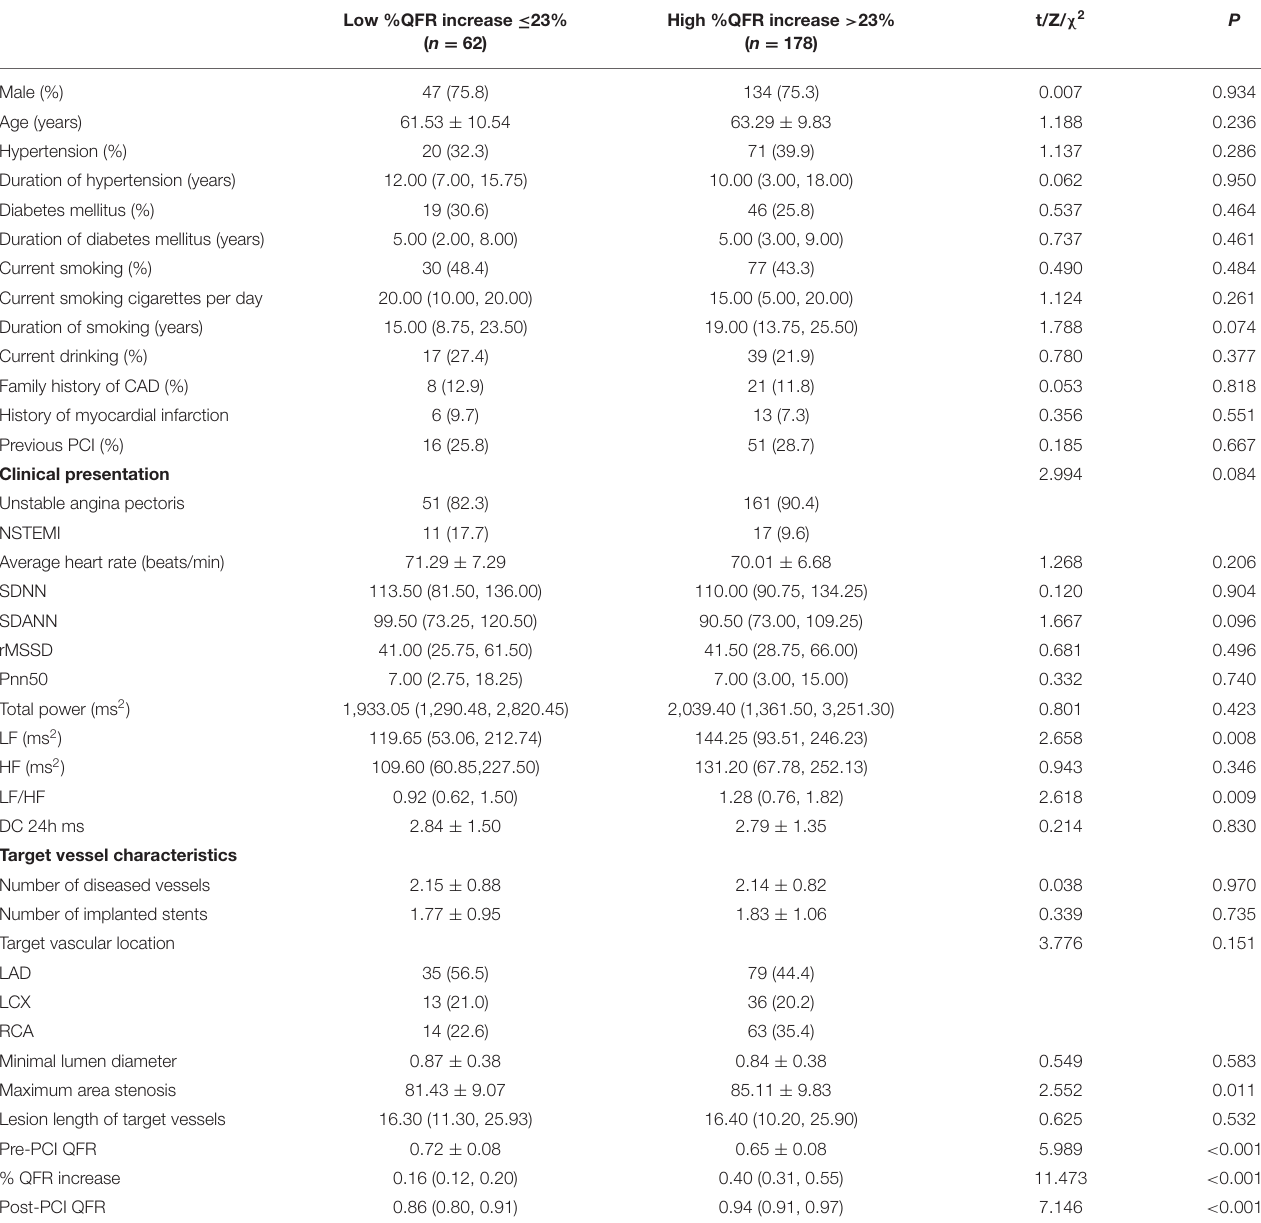
TABLE 5 | Comparison of patient information and target vessel characteristics according to percent QFR increase of the target